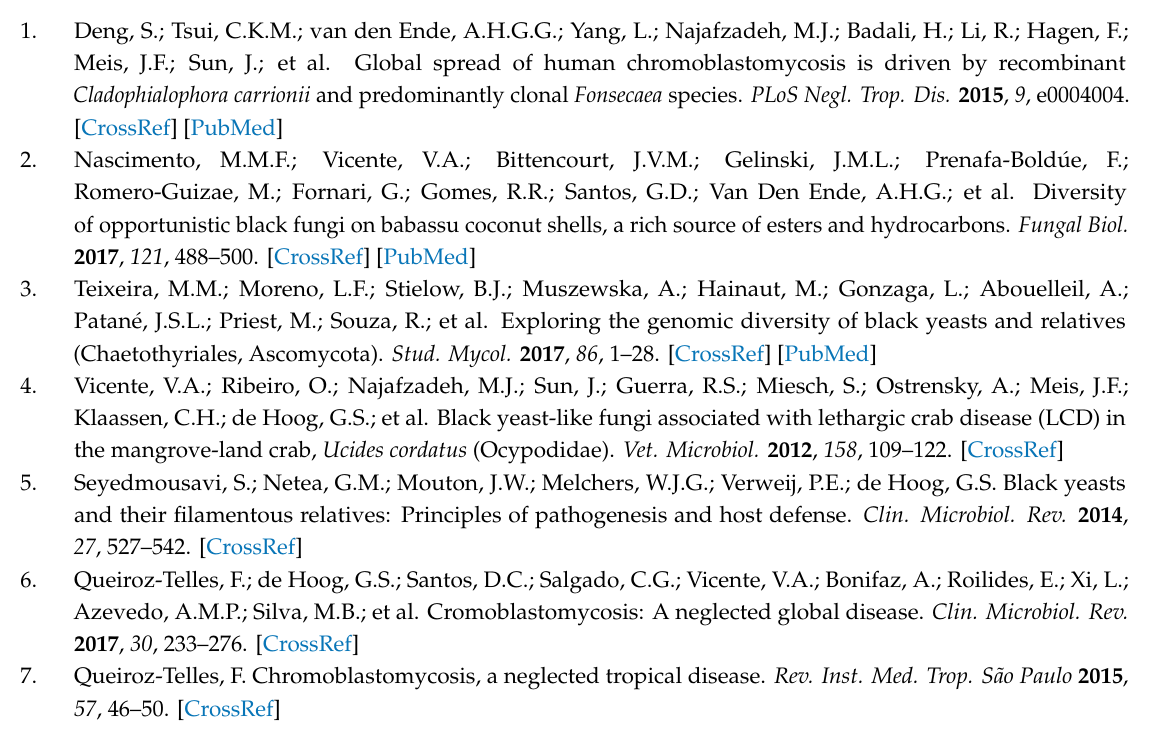
Table S1: Environmental samples from Maranh ã o state, Brazil, analyzed by RCA padlock